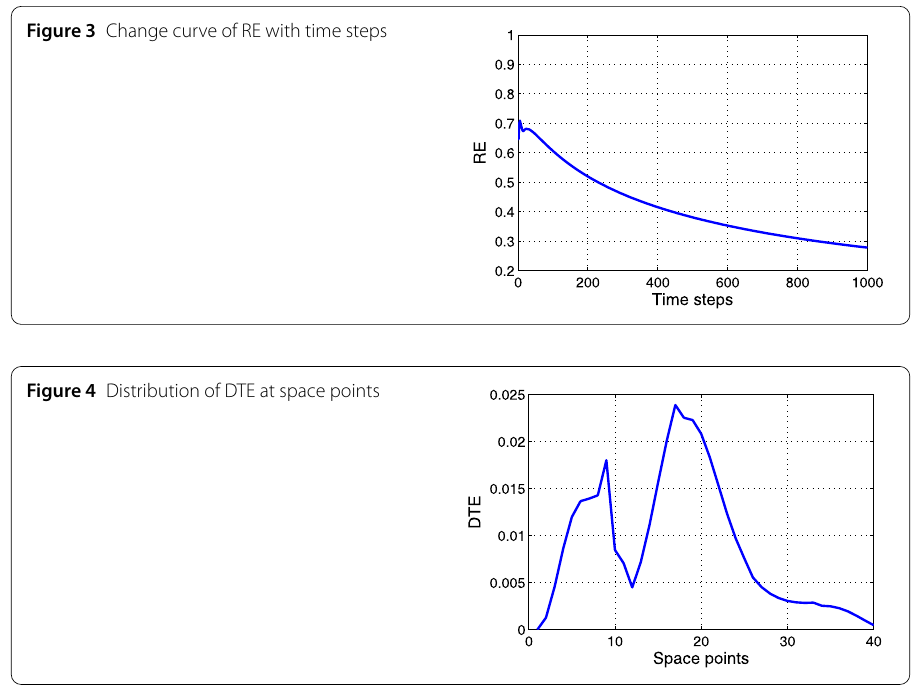
Figure 3 Change curve of RE with time steps